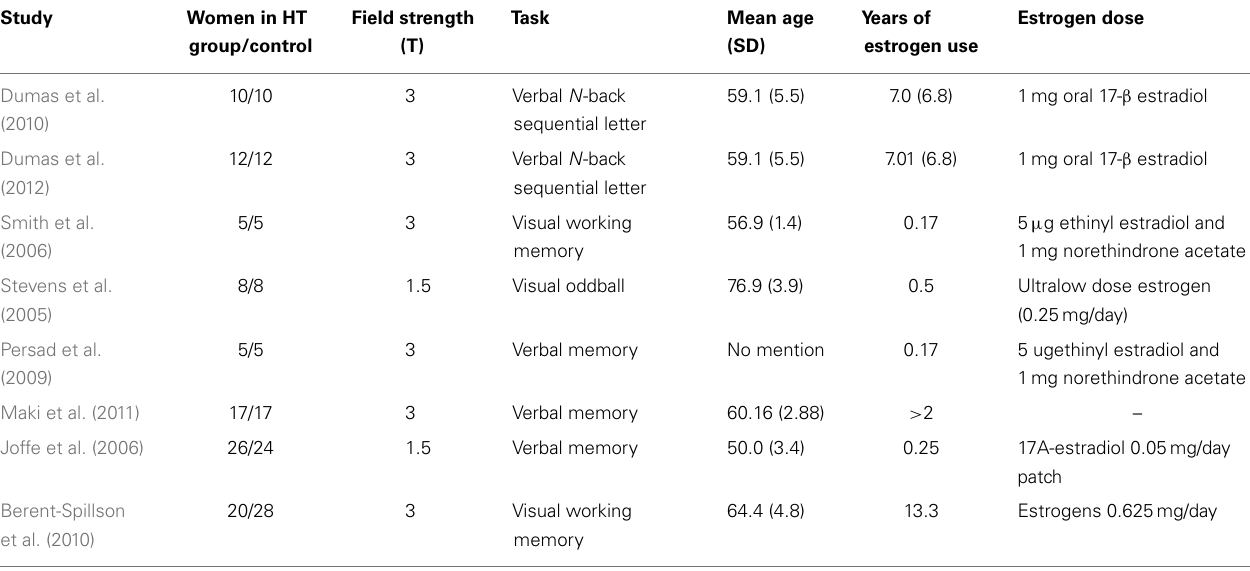
Table 1 | Publications included in the meta-analysis, the tasks they employed, the number of subjects who were investigated, and the mean age of the women and their estrogen dose for theALE meta-analysis .